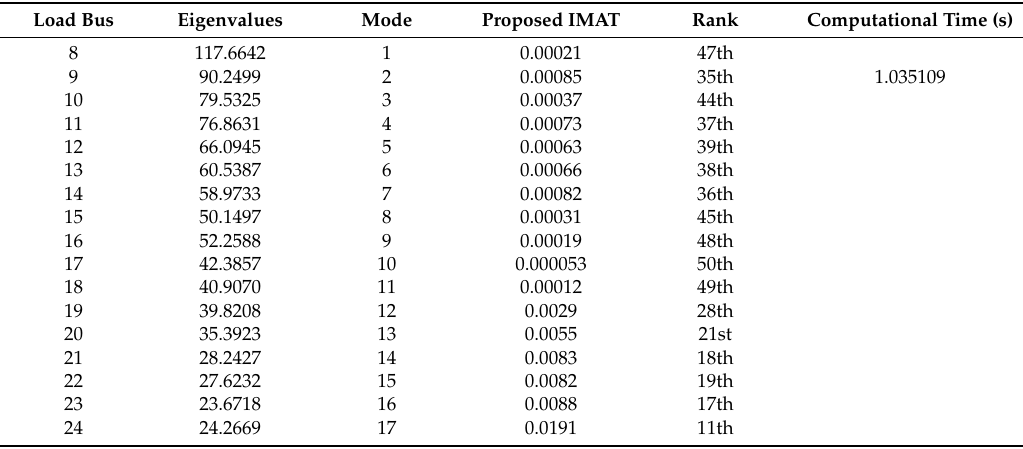
Table 12. Results of the suggested IMAT for the IEEE 57-bus power